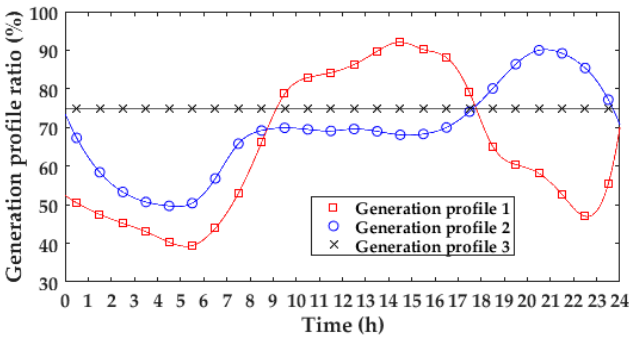
Figure 8. Three different profiles for the dispatched active power of the distributed generator (DG). Table 4. Detailed DG specifications.